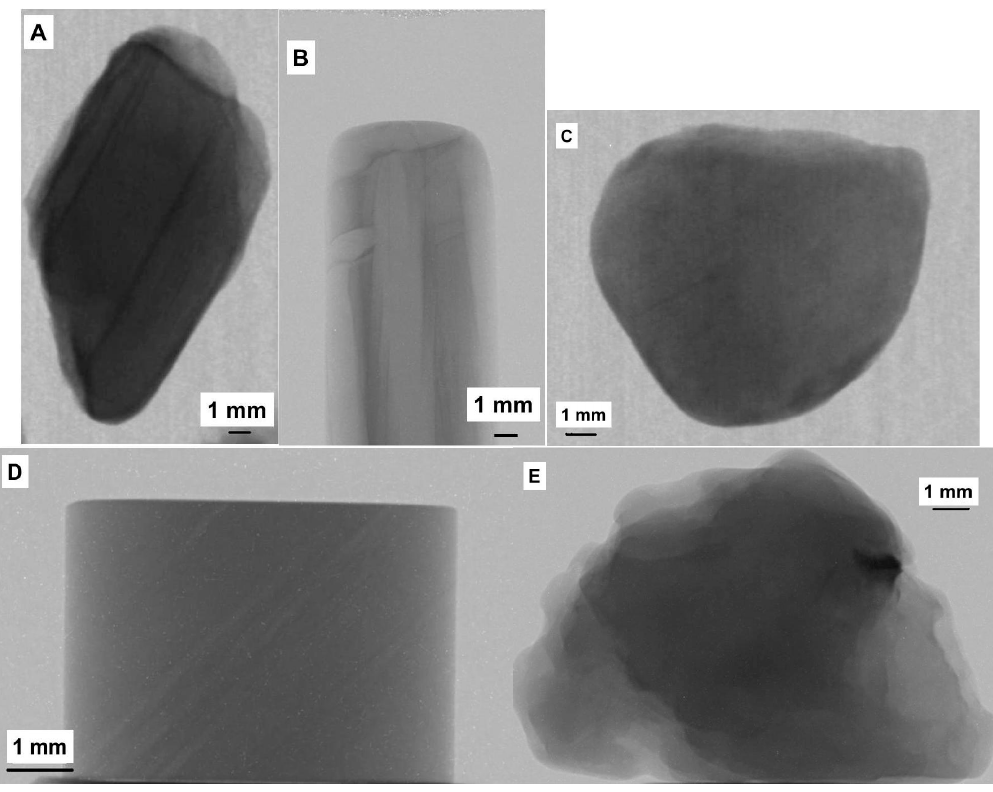
Figure 1. Neutron transmission radiographies of the meteorite samples investigated: ( A ) Agoudal; ( B ) Seymchan; ( C ) Sikhote-Alin; ( D ) Muonionalusta and ( E ) Campo del Cielo.